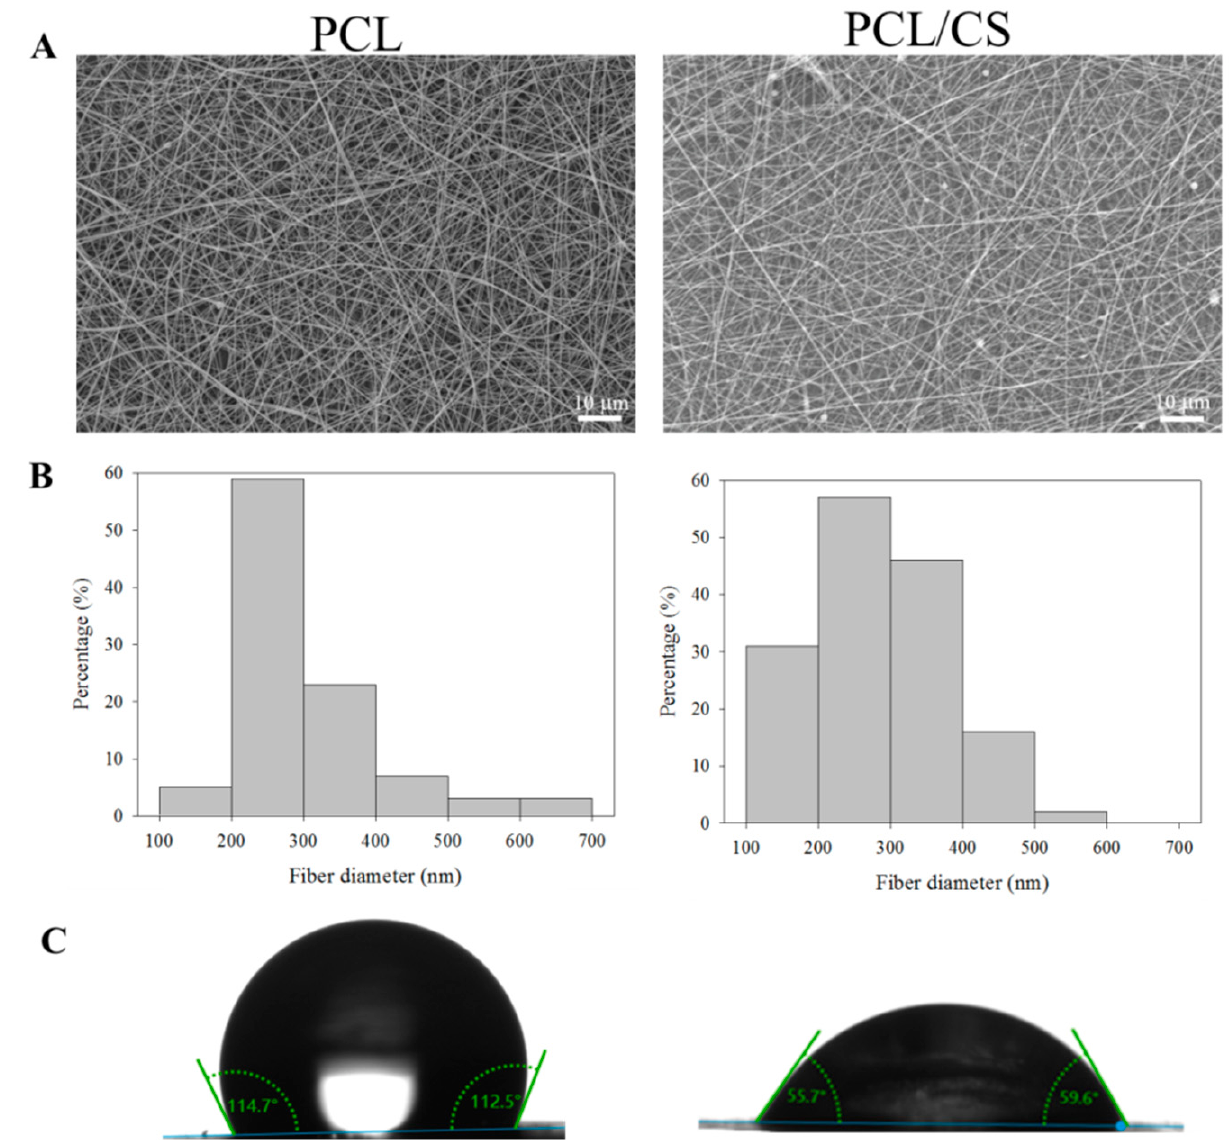
Figure 1. The scanning electron microcopy (SEM) micrograph ( A , bar = 10 µm), fiber diameter distribution ( B ), and water contact angle ( C ) of PCL and PCL/CS nanofiber membranes. Table 1. The physical properties of PCL and PCL/CS (mean ± SD, n = 3).